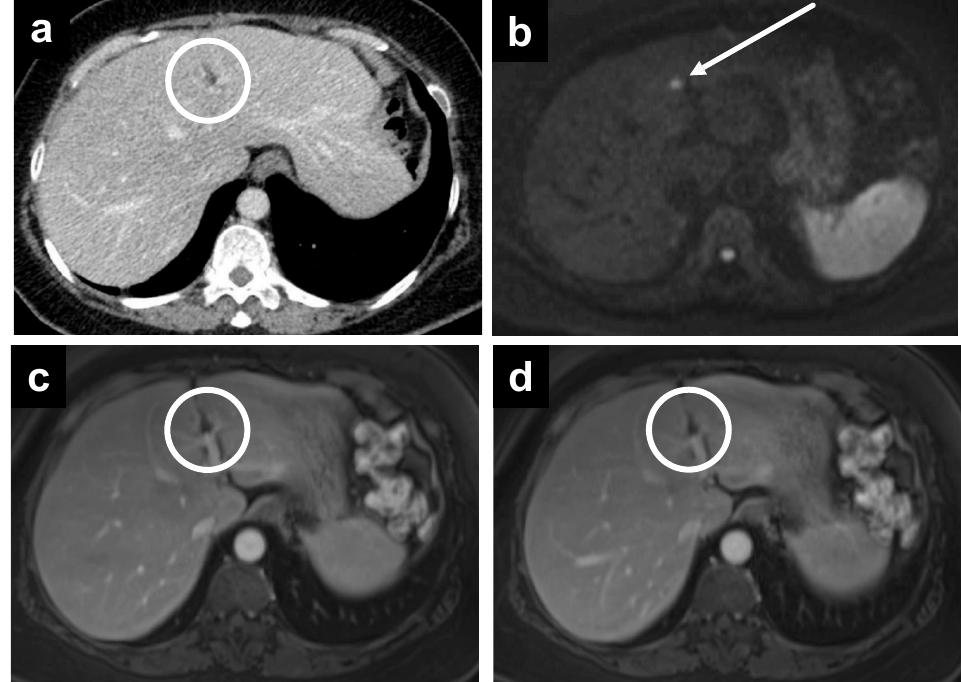
Figure 6. A 61-year-old female with subtle recurrent primary peritoneal carcinoma, a tiny deposit is only well seen on the ( b ) DWI as a hyperintense focus at the falciform ligament (white arrow). A rim-enhancing nodule is barely seen on ( a ) CT, as well as the ( c ) portal venous and ( d ) delayed phases on MRI (white circles).